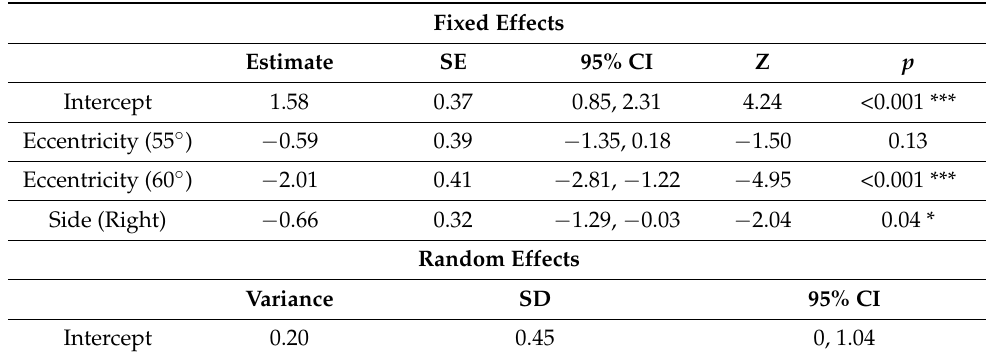
Table 1. The generalised linear mixed effects model (GLMM) results.